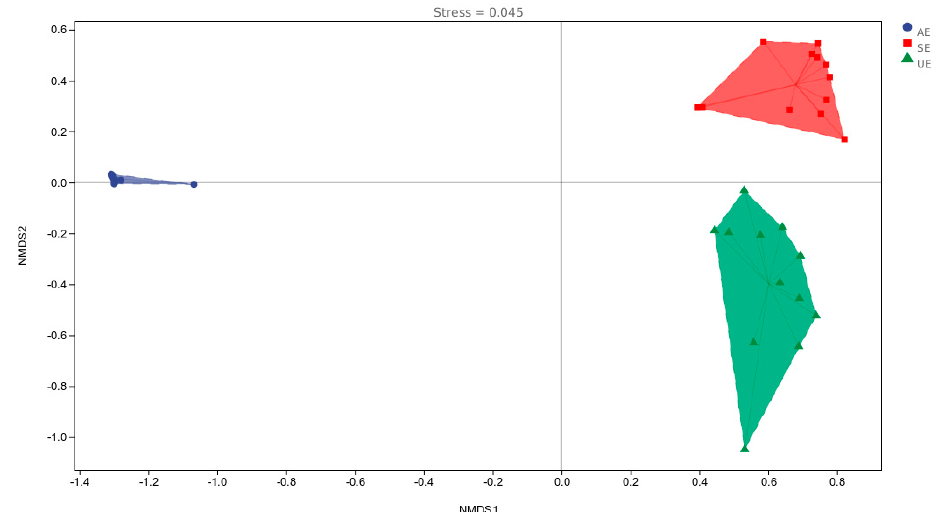
Figure 4. Nonmetric multidimensional scaling (NMDS) analysis of a two-dimensional ordered graph. Each point in the diagram represents a sample, and different colors represent different seasons (groups). It can be approximated that the closer (farther) the distance between two points, the smaller (larger) the difference in microbial communities between the two samples. (Subgroup AE: Autumn of 2020. Subgroup SE: in the spring of 2021. Subgroup UE: the summer of 2021).